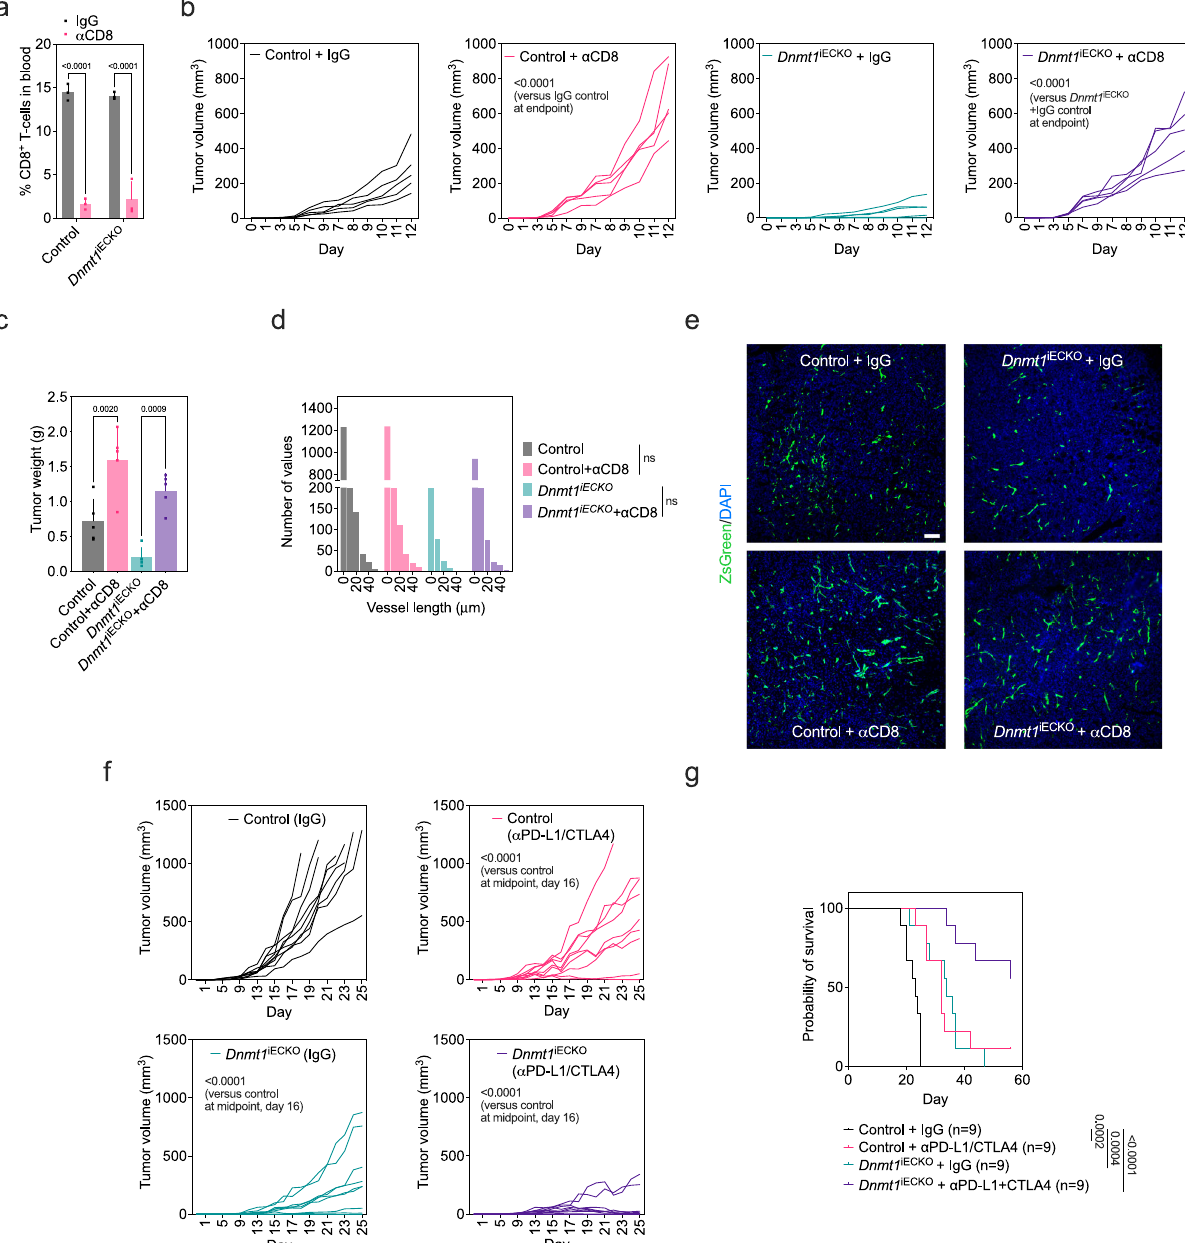
Fig. 4 | CD8-blocking antibodies rescue tumor growth, whereas ICB ef fi cacy is enhanced in Dnmt1 iECKO mice. a Validation of depletion of CD8 + cells in blood drawn from the indicated mice ( n = 3 ). Data were analyzed by ANOVA followed by Sidak ’ s multiple comparisons test. b Tumor growth analysis in control versus Dnmt1 iECKO micetreatedwithIgGcontrolorCD8-blockingantibodies( n = 5 ).Results were analyzed using ANOVA followed by Tukey ’ s multiple comparisons